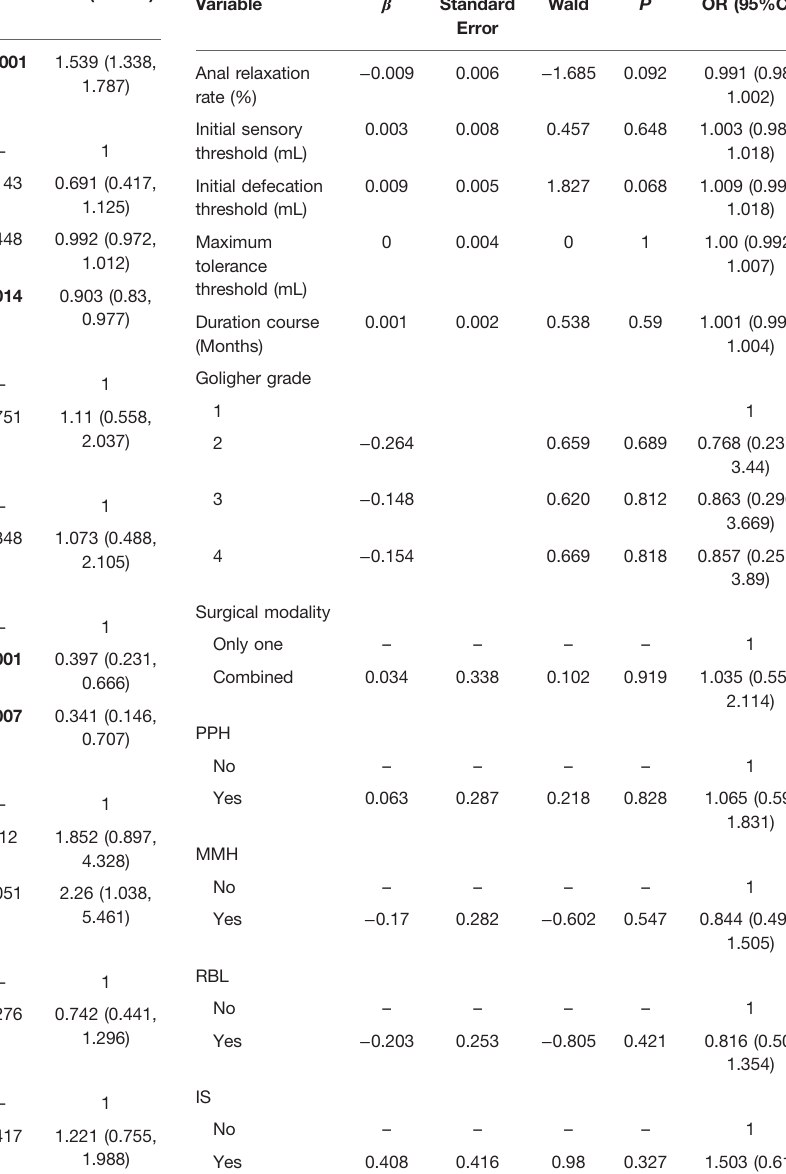
TABLE 7 | Univariate analysis for hemorrhoid